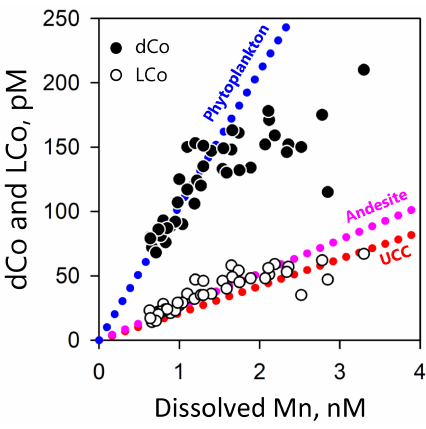
Figure 11. Cobalt and Mn in the Peru shelf OMZ (GP16 sta- tions 1–5, O 2 <20uM). Dissolved cobalt (dCo, closed circled) and labile cobalt (LCo, white) follow positive linear relationships with dMn. The LCo slope (18mMM − 1 ) approximates the Co : Mn ra- tio in the upper continental crust and andesite (red and pink lines, 21 and 26mMM − 1 , respectively), suggesting that it derives from a crustal source. The mean pCo : pMn ratio from phytoplankton- dominated particles collected in the upper 40m over the shelf (blue line, 105mM M − 1 ) is greater than dCo : dMn slope (42mMM − 1 ) , indicating that dCo and dMn concentrations in the Peru shelf OMZ represent a combination of biomass remineralization and sedimen- tary